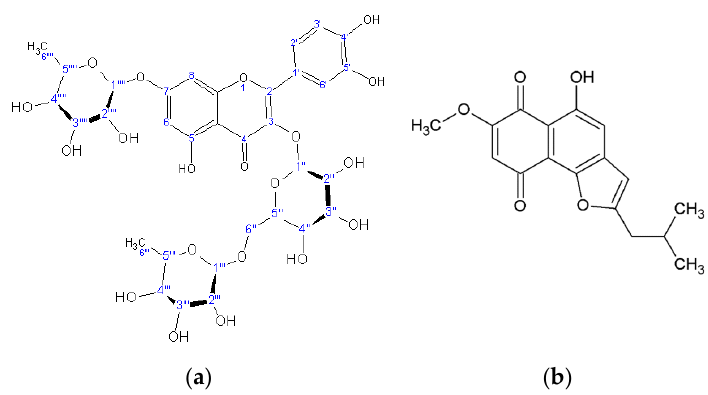
Figure 1. Chemical structure of quercetin 3 ‐ rutinoside ‐ 7 ‐ rhamnoside ( a ) and rinderol ( b ).